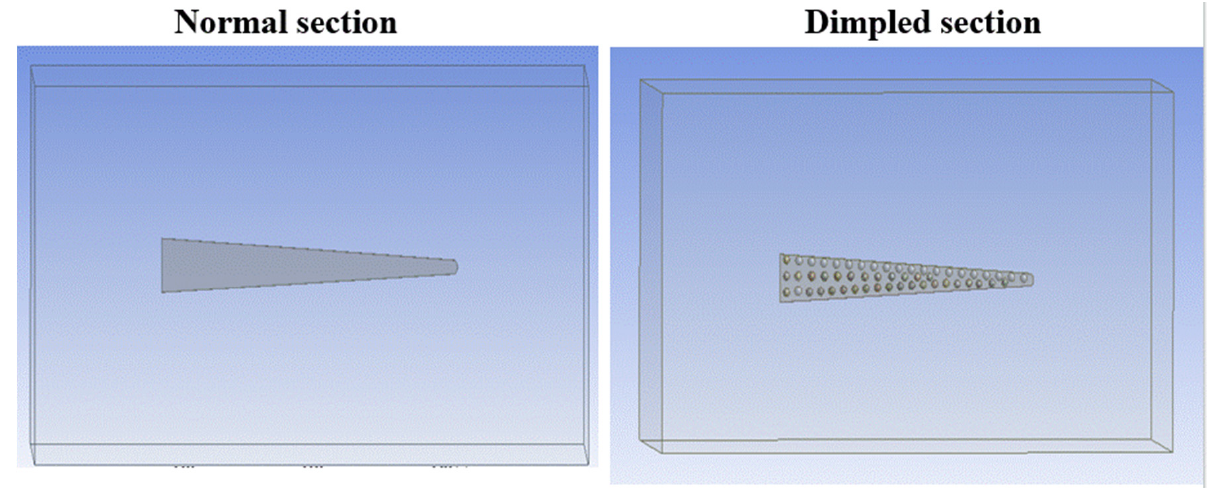
Figure 7. Geometric enclosure on the normal and dimpled sections of a turbine blade.